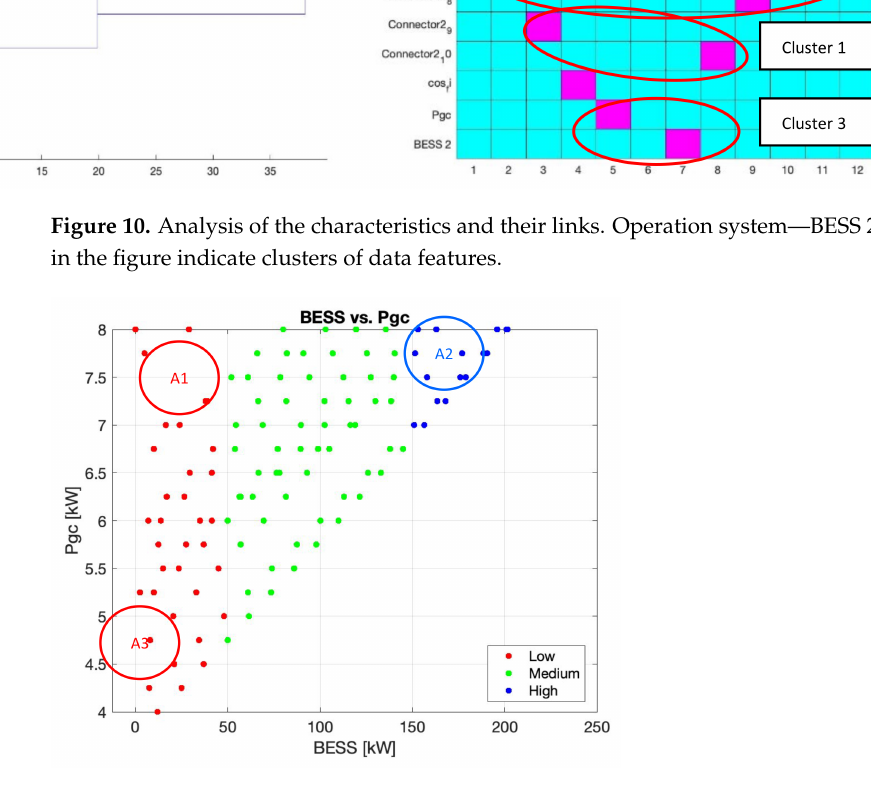
Figure 11. Power flow data distribution–optimal operation of connecting points, BESS-only operation system. In the figure, circles with low data density have been marked with circles.